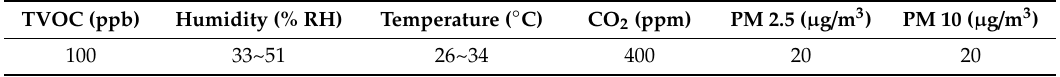
Table 2. The range of initial states of experiment.